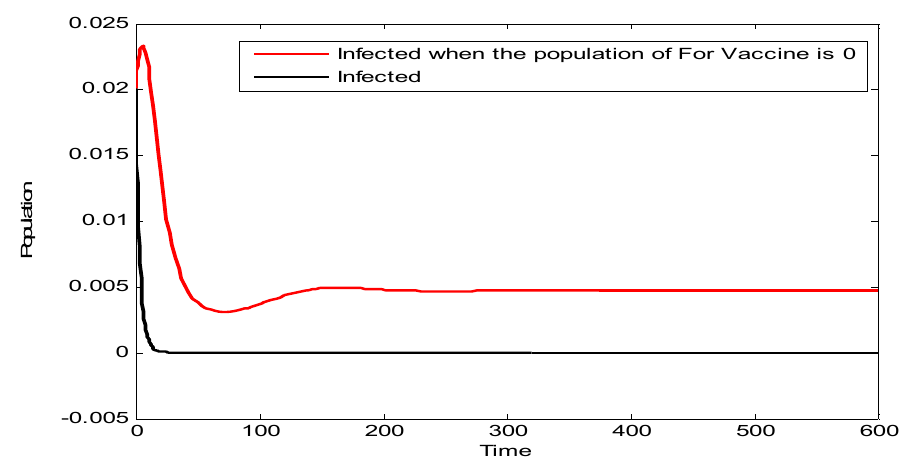
Figure 2. Effect of eliminating the pro-vaccine population.